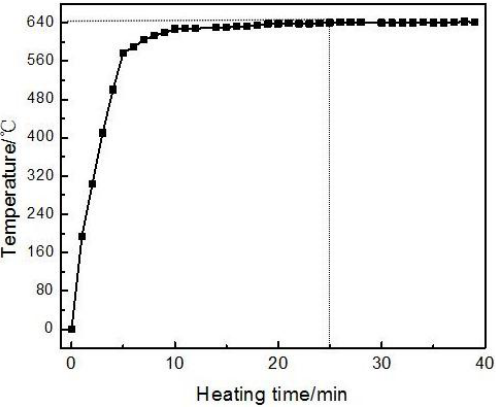
Figure 5. Temperature variations in the specimen with heating time.